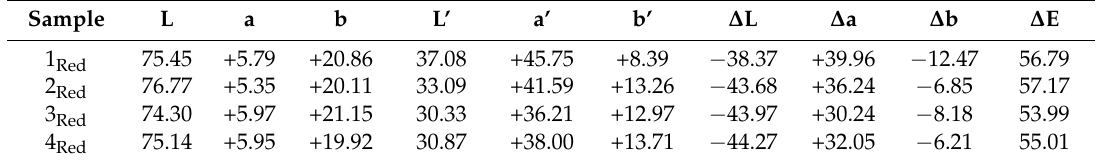
Table 2. L 4 (2 3 ) orthogonal test of chromatic aberration with reactive brilliant red.